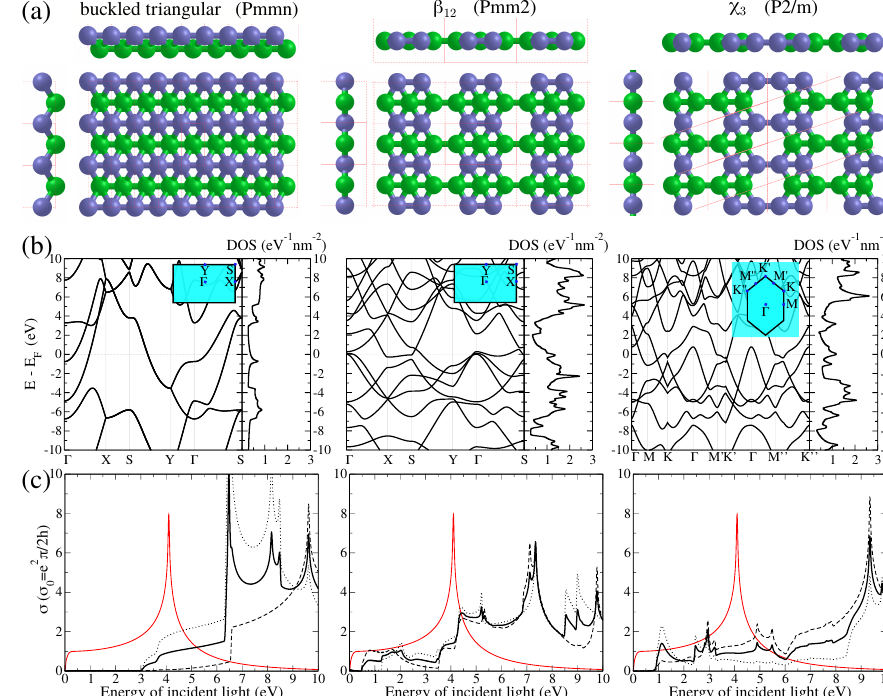
Figure 4. Electronic and optical properties of borophene monolayers: ( a ) Three 2D crystal polytype structures of borophene with increasing boron vacancies, i.e., buckled triangular, β 12 , and χ 3 , with in ( b ) the corresponding electronic band structures and in ( c ) the corresponding longitudinal optical ( σ xx + σ yy ) in dotted, dashed, and thick black line, conductivities σ xx , σ yy , and their averaged 1 2 respectively. Graphene optical conductivity is also given in red line.